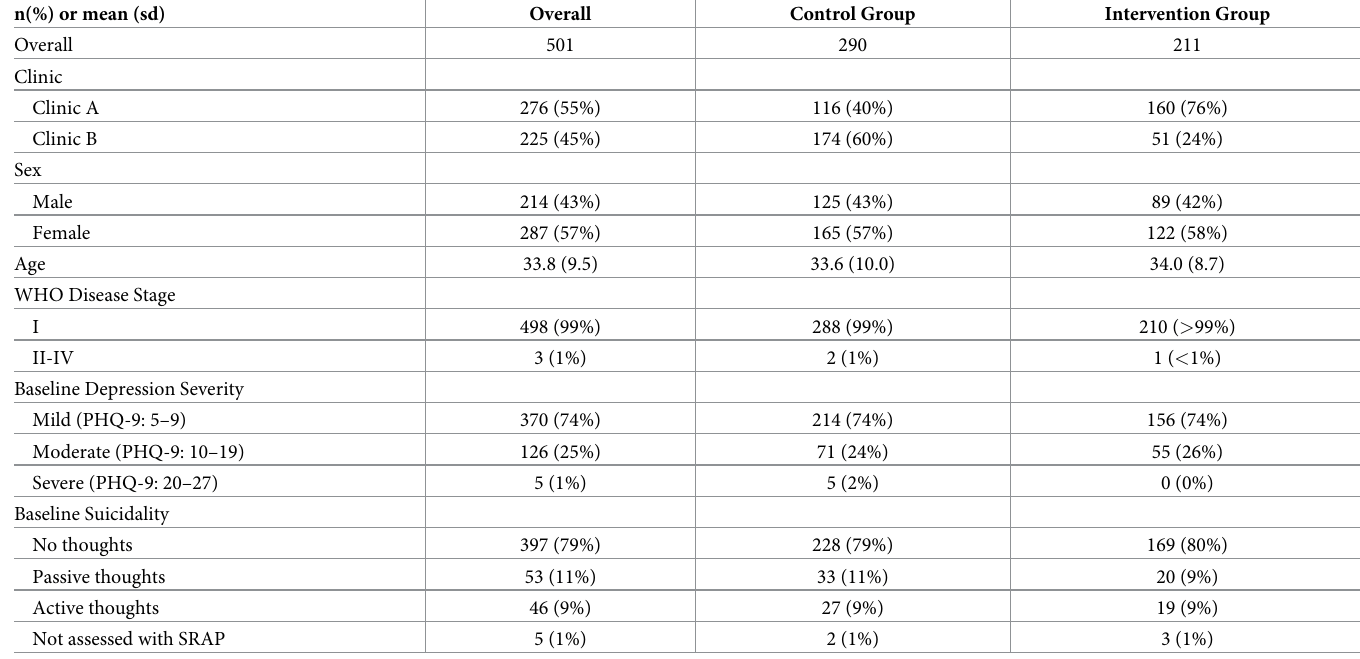
Initiating depression treatment. Among the control group, 89% of participants with mild depressive symptoms and 80% participants with moderate to severe depressive symptoms received some additional counseling by ART clinicians (“standard depression care” during the Table 2. Participant characteristics (N =